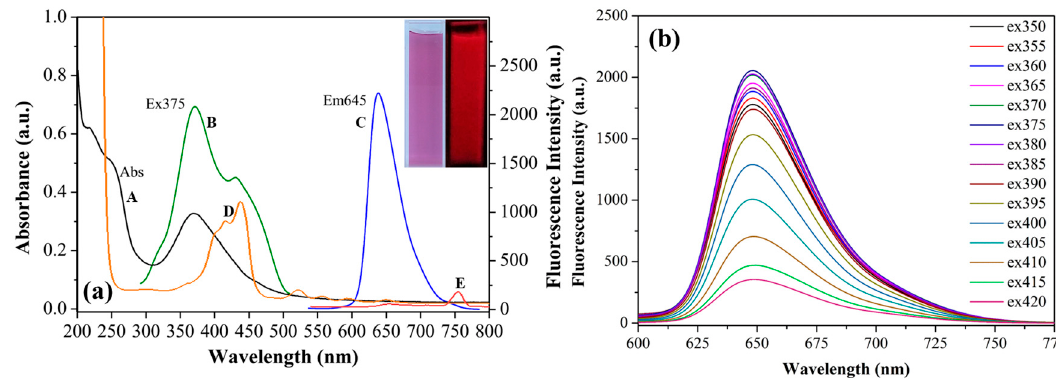
Figure 4. ( a ) UV-Vis absorption (A), fluorescence excitation ( λ ex , B) and emission ( λ em , C) spectra of PCDs in aqueous solution; UV-Vis absorption (D) and fluorescence emission ( λ em , E) spectra of TCPP in aqueous solution; The inset: The photographs of PCDs aqueous solution under daylight (left) and UV light (right). ( b ) Fluorescence emission spectra of PCDs with excitation wavelengths from 350 to 420 nm in 5 nm intervals.